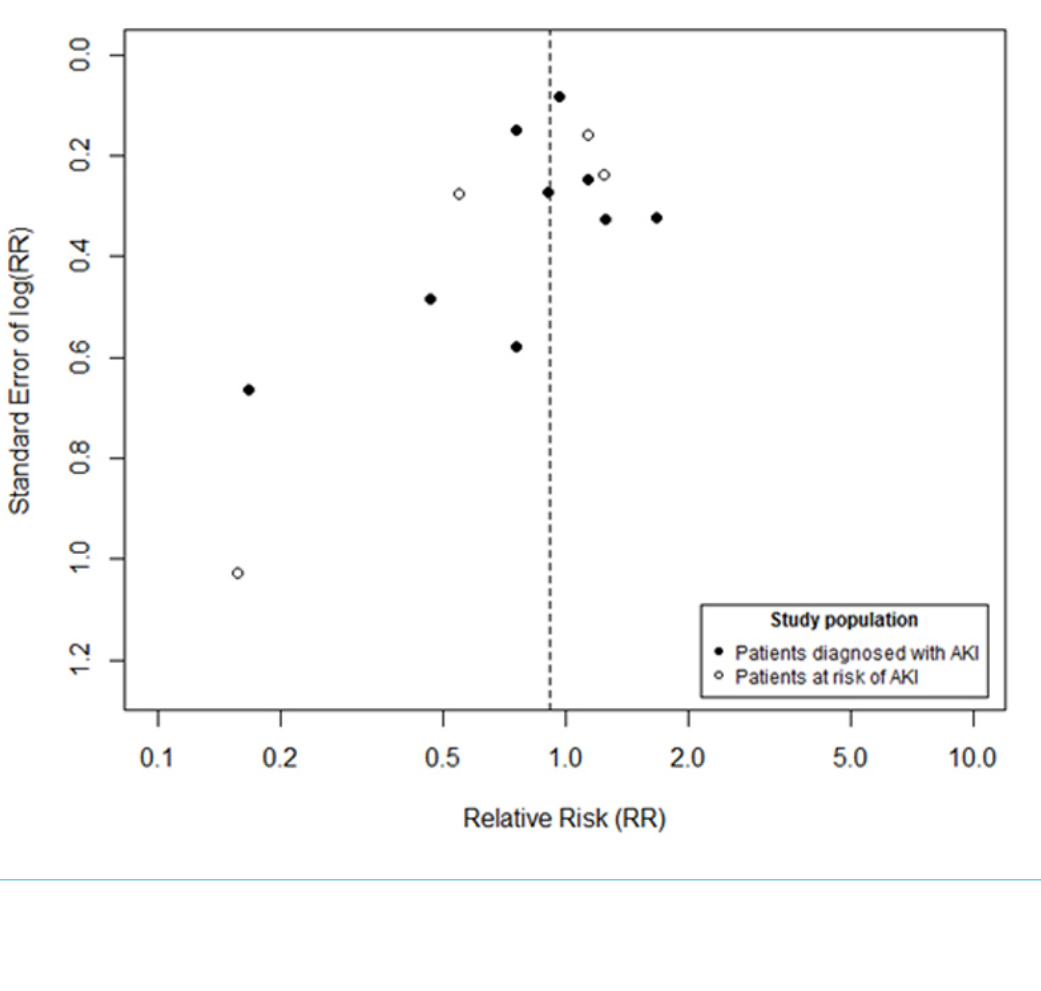
Figure S1: Funnel plot of the 9 randomised controlled trials in patients with acute kidney injury and the 4 trials in patients at risk for acute kid- ney injury. X axis is the risk ratio for mortality on a natural logarithm scale. Y axis is the standard error of the natural logarithm of risk ratio for